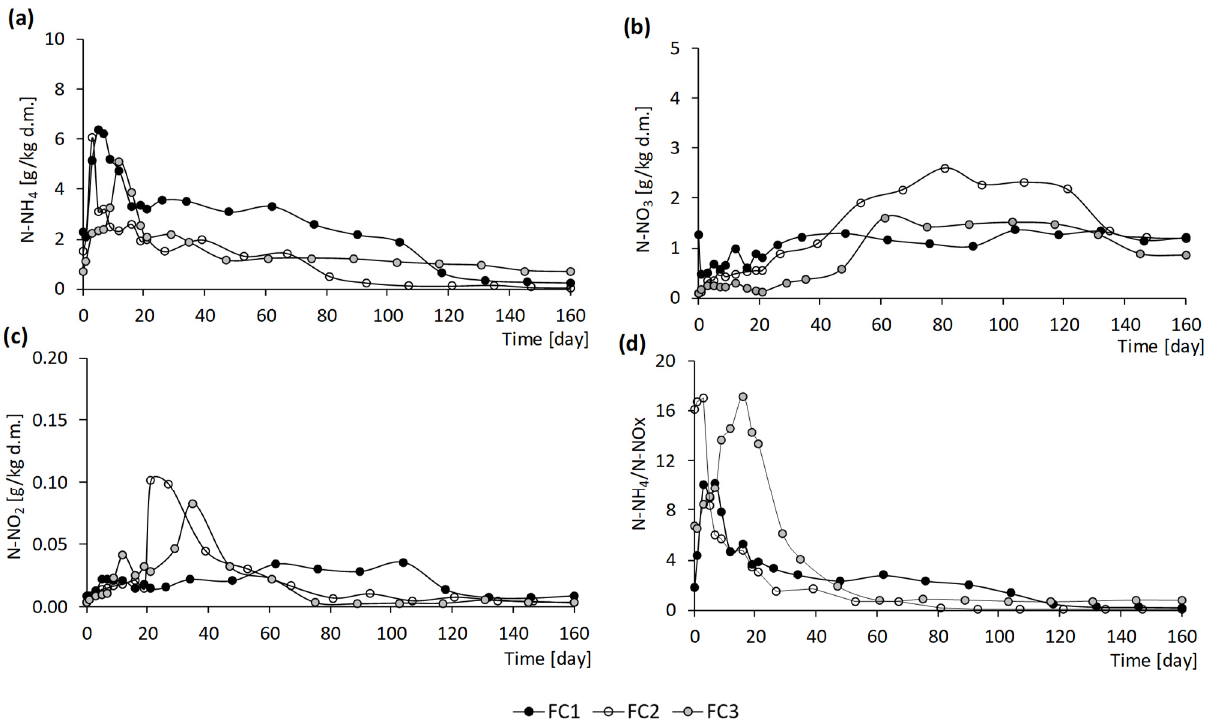
Figure 3. Changes in the nitrogen forms ( a – c ) and nitrification index (N-NH 4 /N-NO x ) ( d ) during composting (until the 21st day in the bioreactor, then in the windrow).